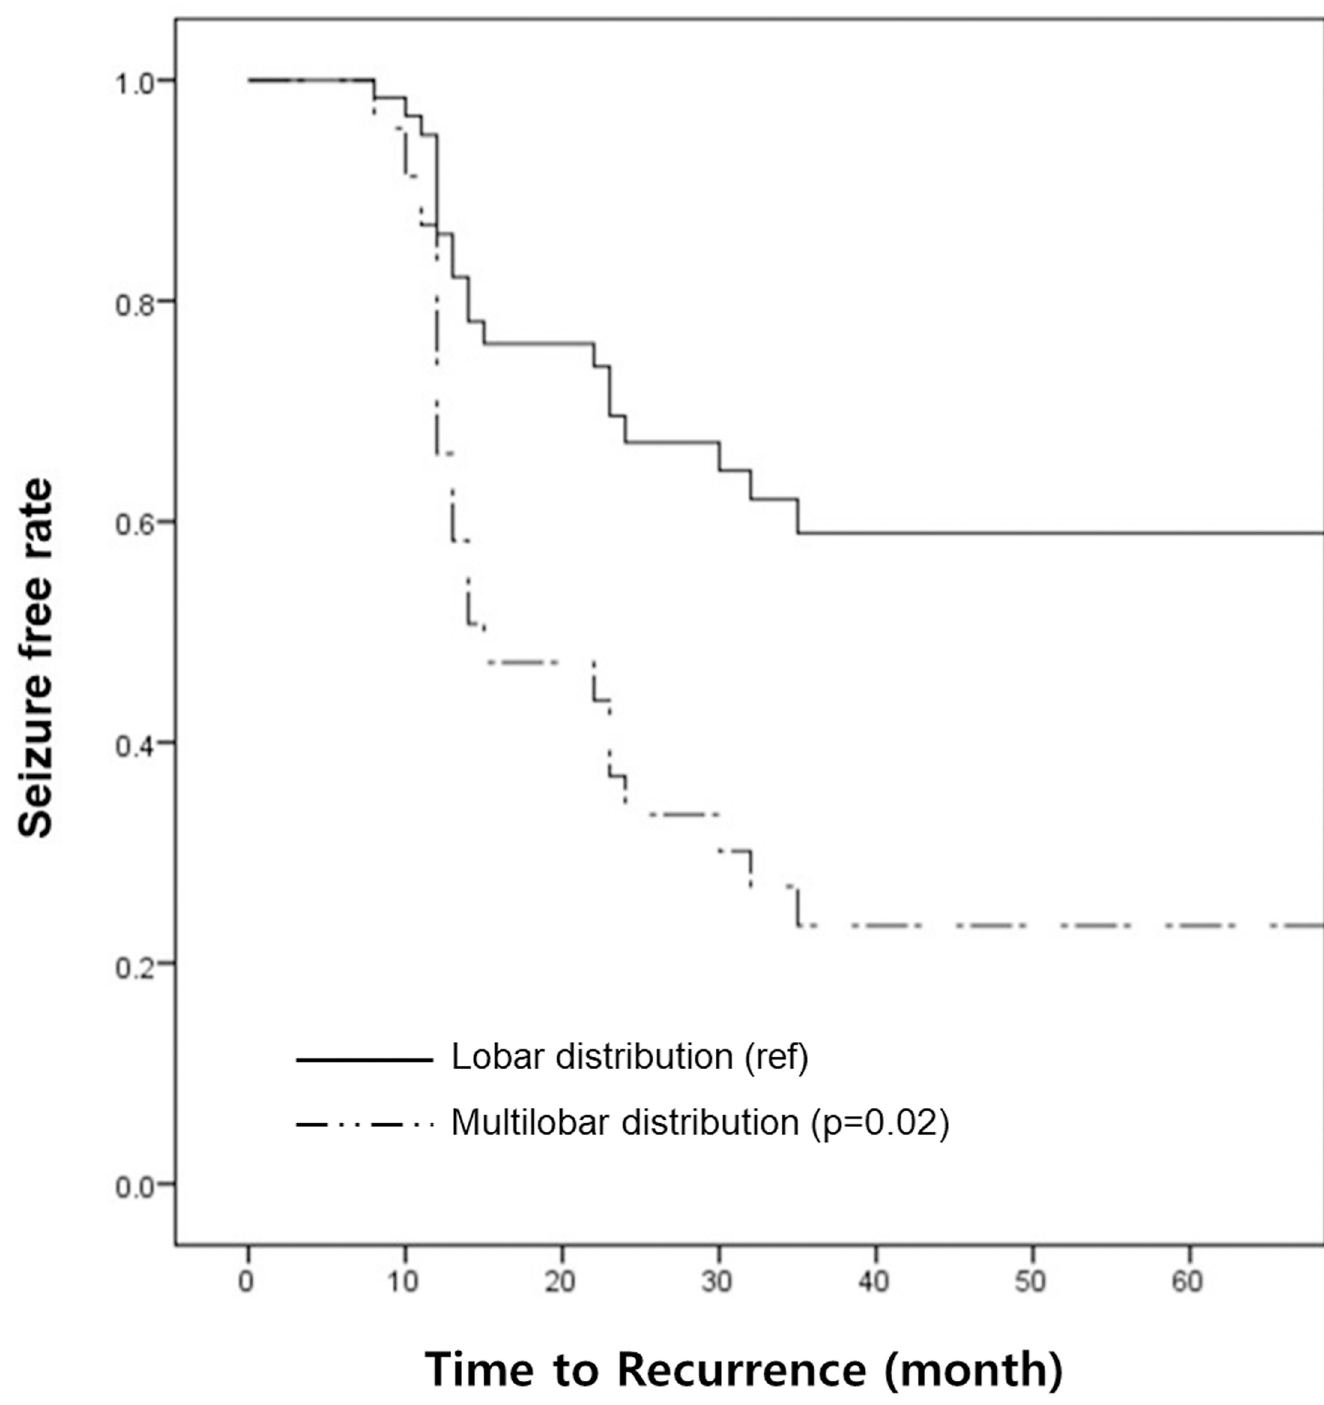
Fig 3. Kaplan-Meier survival curves according to SISCOM distribution in the MR-negative group. The survival curves show significantly more frequent recurrence in multilobar distribution at SISCOM finding (solid line: Lobar distribution, dashed line: Multilobar distribution).